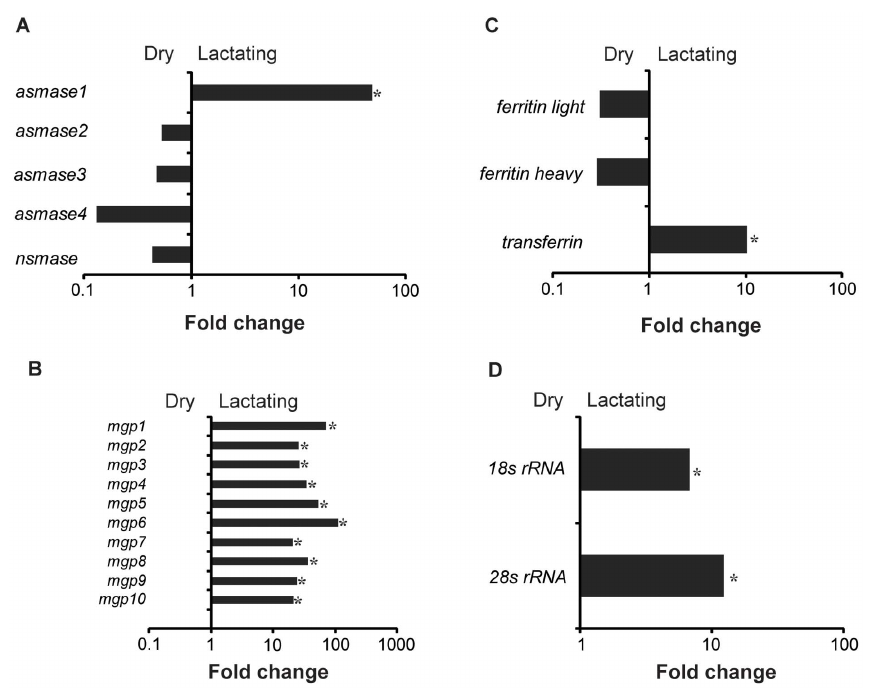
Figure 3. Summary of specific genes that are differentially expressed in lactating compared to dry flies. (A) Sphingomyelinase genes, asmase1–4 and nsmase . (B) Milk gland proteins genes, mgp1–10 . (C) Iron-associated genes, non-hemecontaining ferritin , ferritin light , ferritin heavy and transferrin . (D) Ribosomal RNAs, 18S rRNA and 28S rRNA . *, significantly different expression values from B, Kal’s test with Bonferroni correction, P , 0.05.